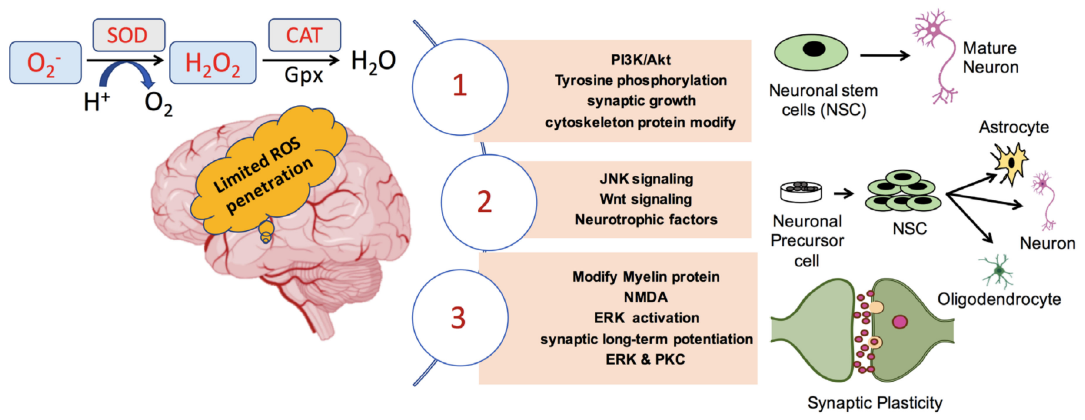
Figure 2. ROS mediated pathways that influence neuronal maturation and di ff erentiation as well as synaptic plasticity in the